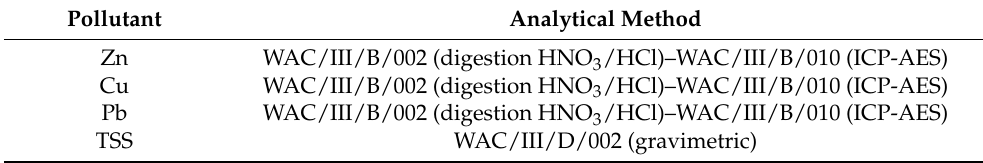
Table 2. Analytical